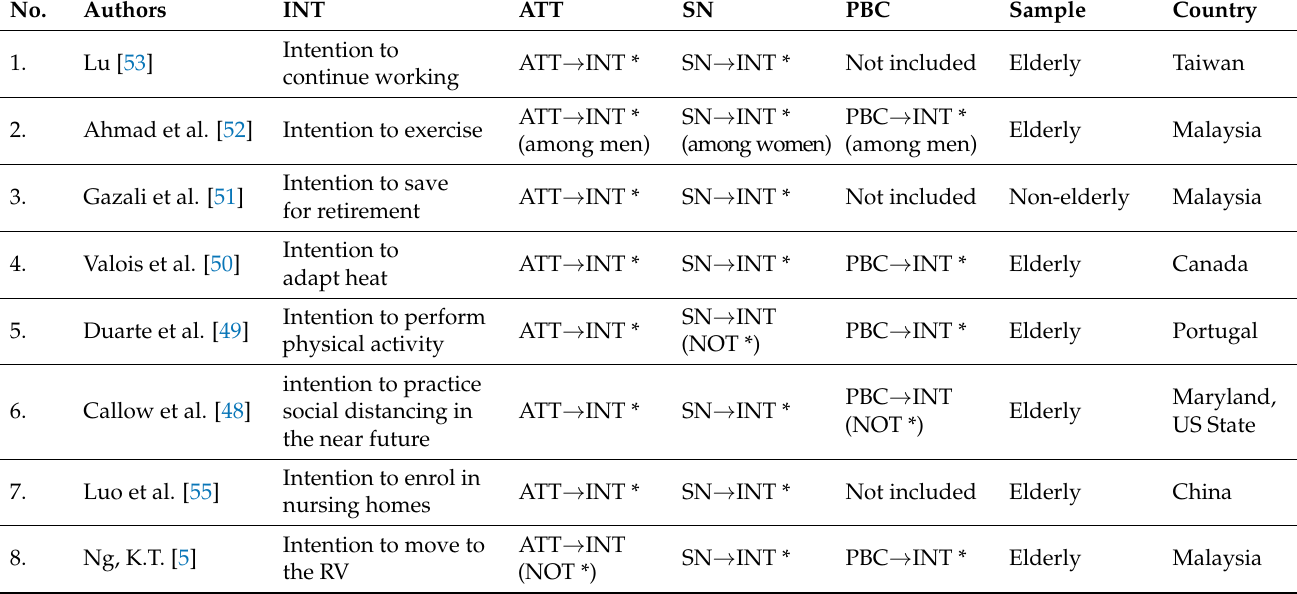
Table 1. Empirical evidence on the relationship between various